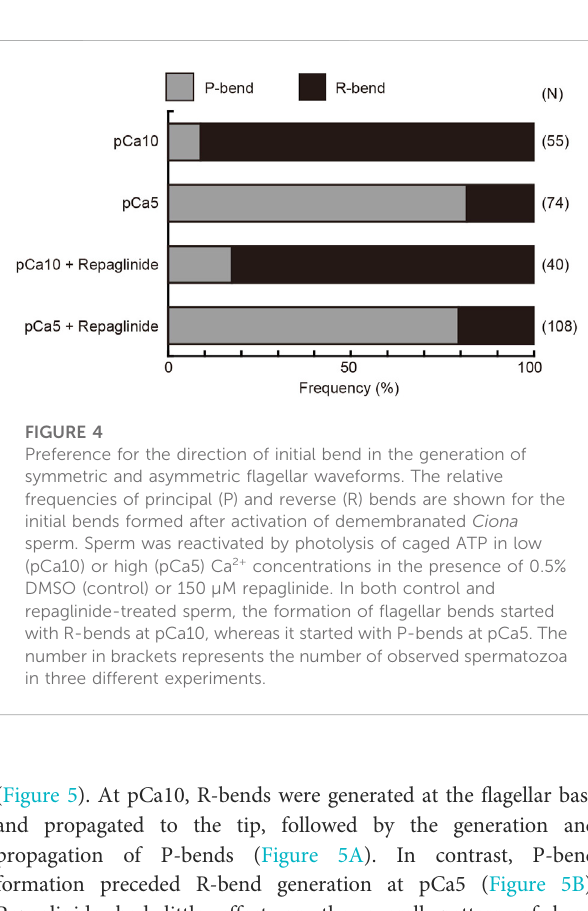
(Figure 5). At pCa10, R-bends were generated at the fl agellar base and propagated to the tip, followed by the generation and propagation of P-bends (Figure 5A). In contrast, P-bend formation preceded R-bend generation at pCa5 (Figure 5B).